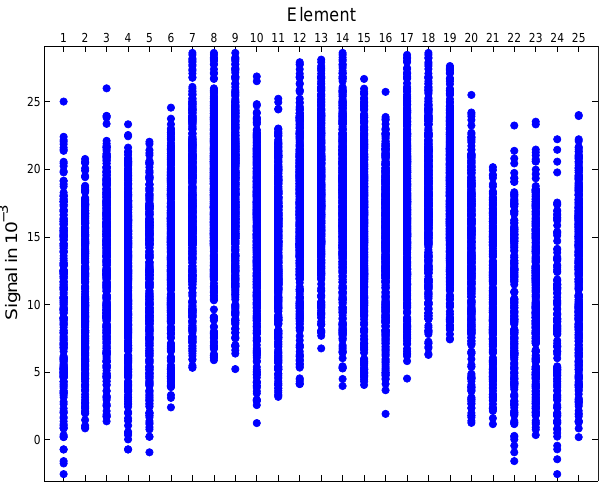
Fig. 10. Signal list for system 3 with additive noise using time se- ries of 100000yr. Ordinate: absolute signal; abscissa: elements of the system. Any area that has been calculated during the analysis is represented at the ordinate value of its signal. All elements that are part of this area are marked as blue dots. Parameter settings corre- spond to set 1 in Table 4.